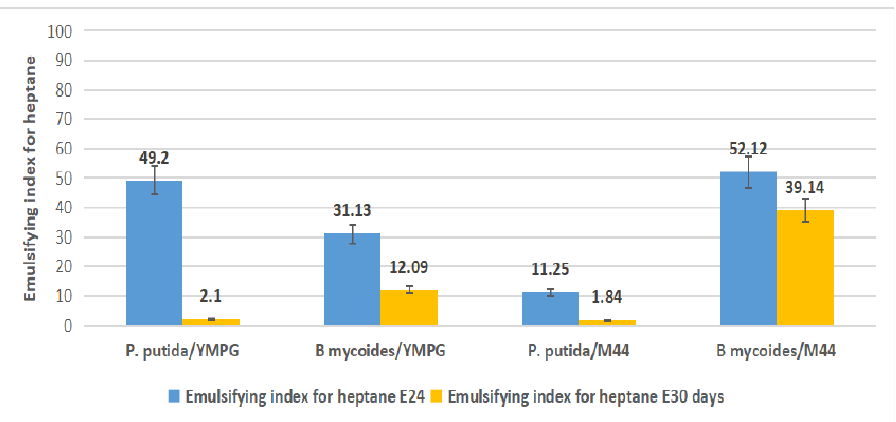
Figure 13. Emulsifying index for heptane (YMPG and M44).